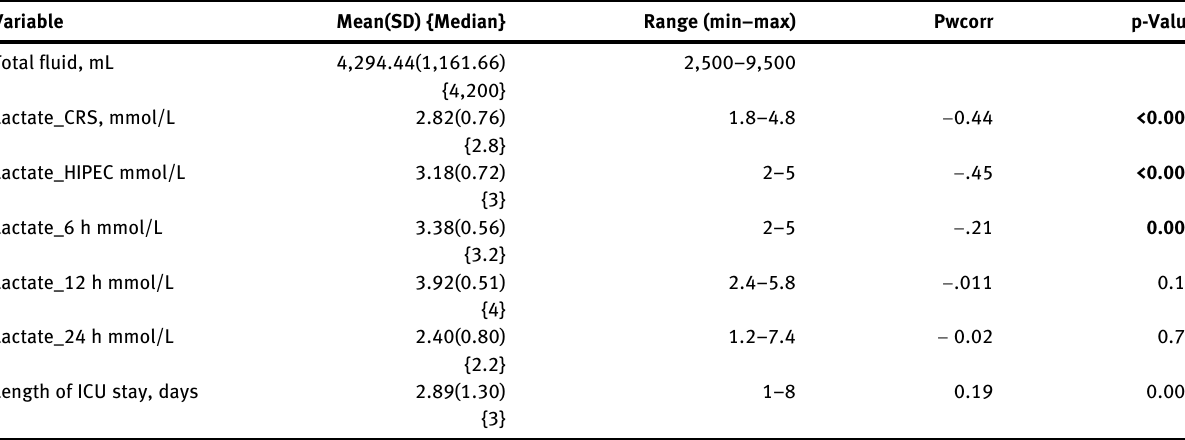
Table  : Correlation between total fl uid and different perioperative parameters.